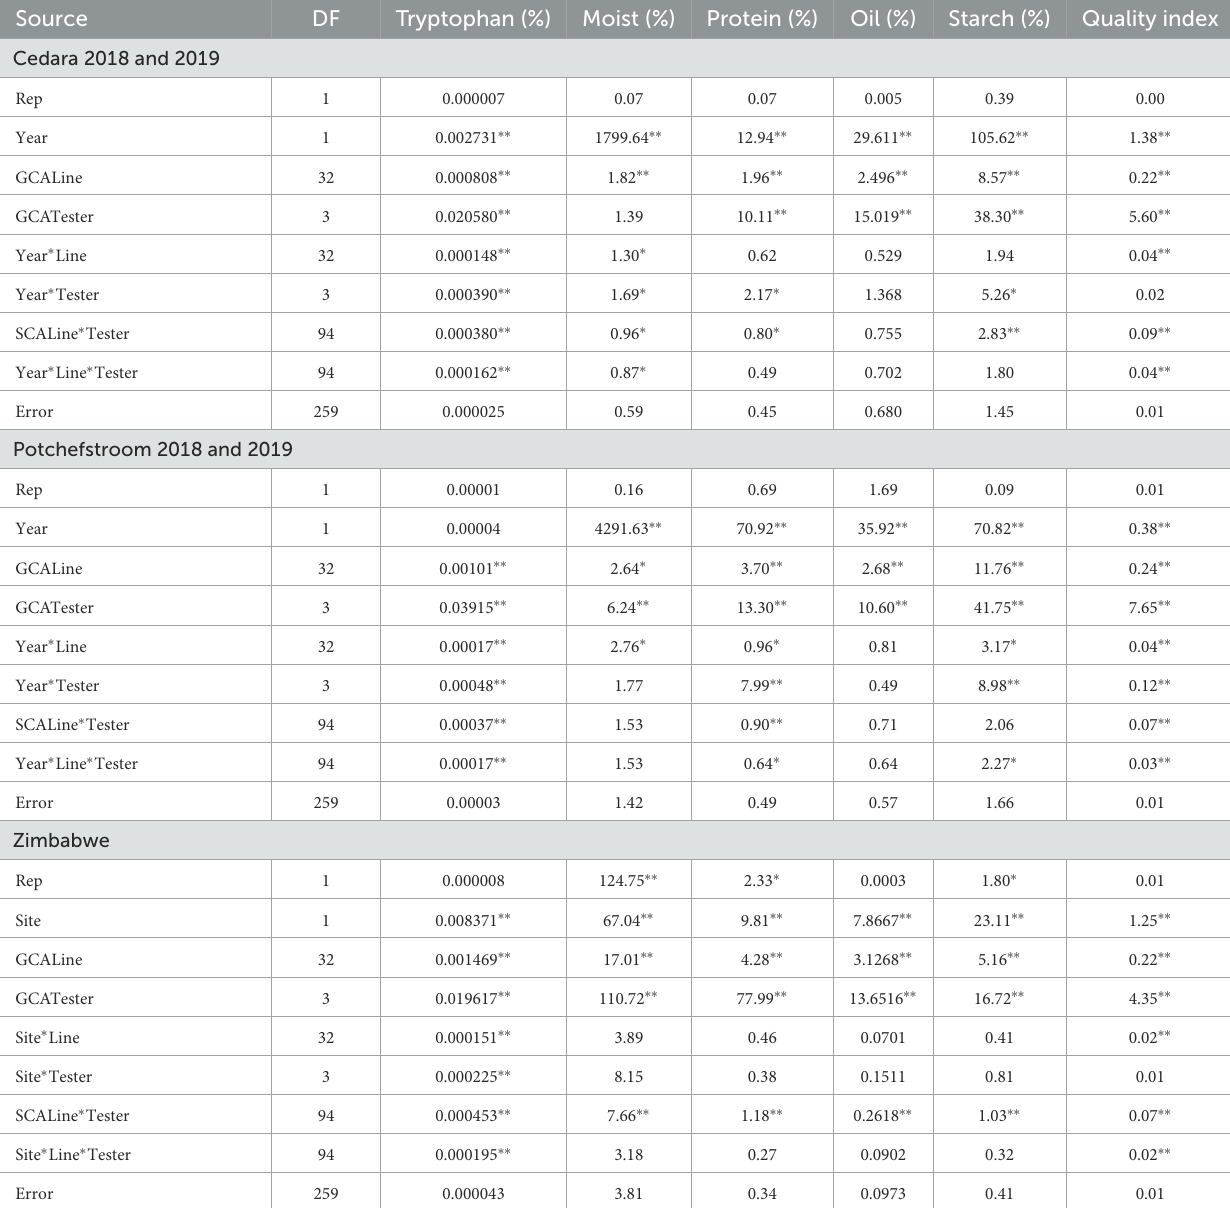
TABLE 5 Mean squares from analysis of variance for general and specific combining ability for six quality traits of 33 inbred lines and four testers at Potchefstroom, Cedara and Zimbabwe during the 2017/2018 and 2018/2019 cropping seasons. Source DF Tryptophan (%) Moist (%) Protein (%) Oil (%) Starch